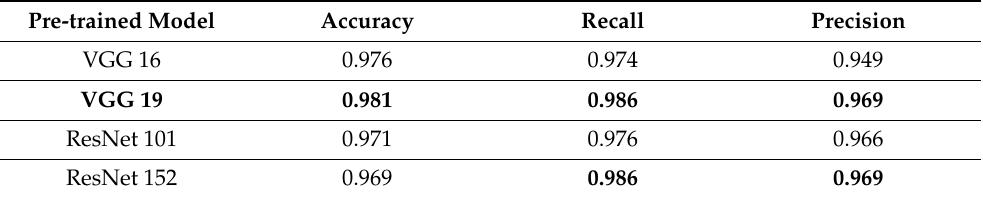
Table 3. Performance using Gaussian